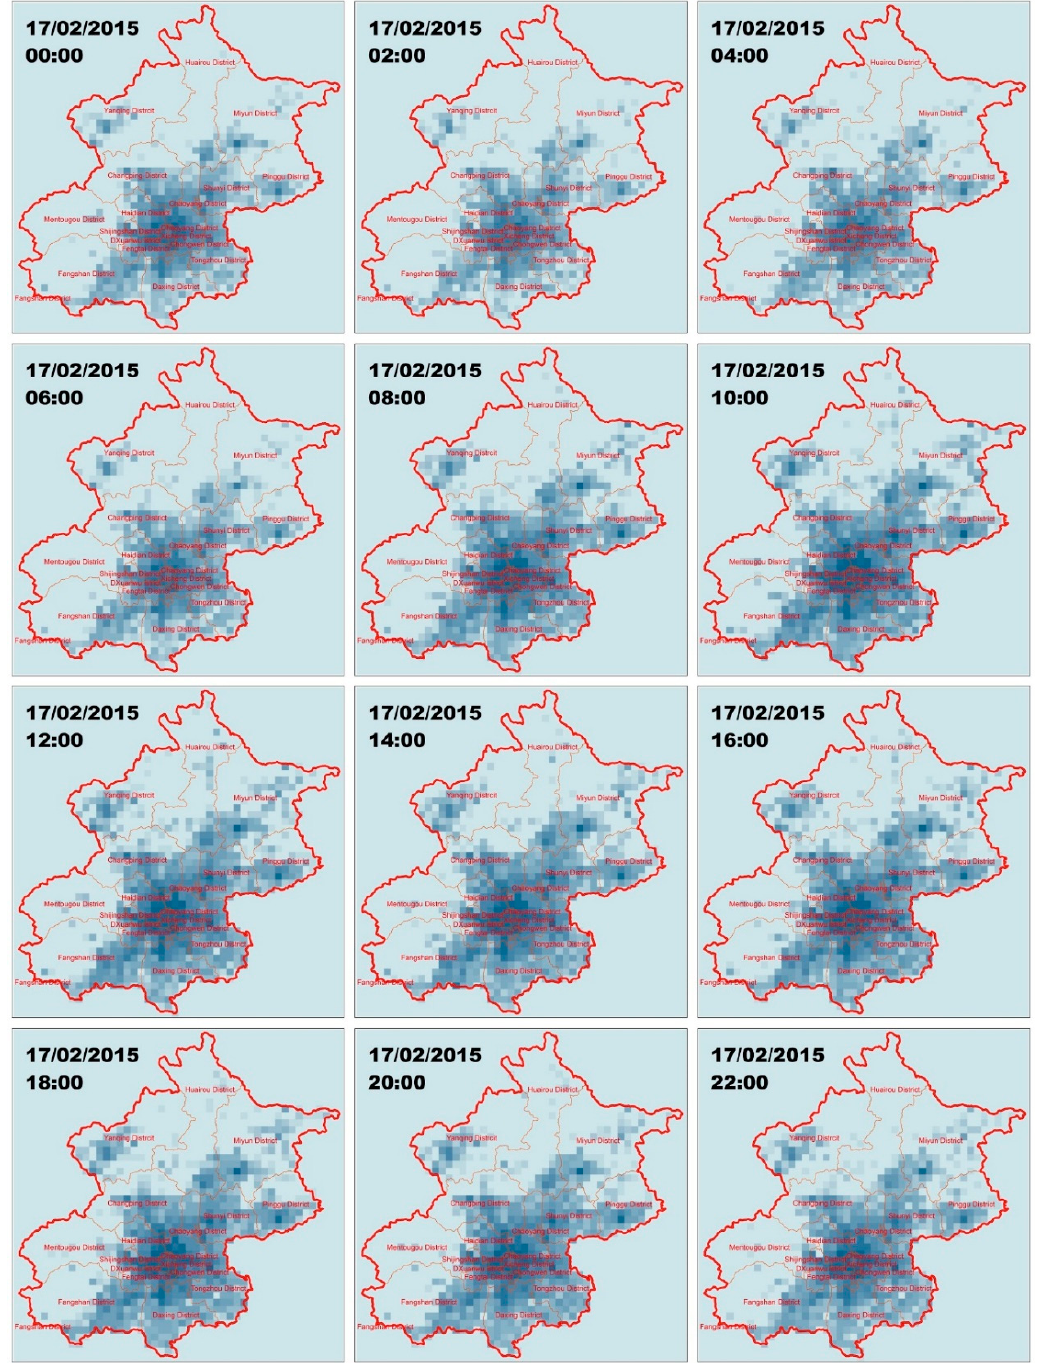
Figure 10. Mobile users’ distributions generated using kernel density estimation method on 17 February 2015 at a higher spatial resolution.